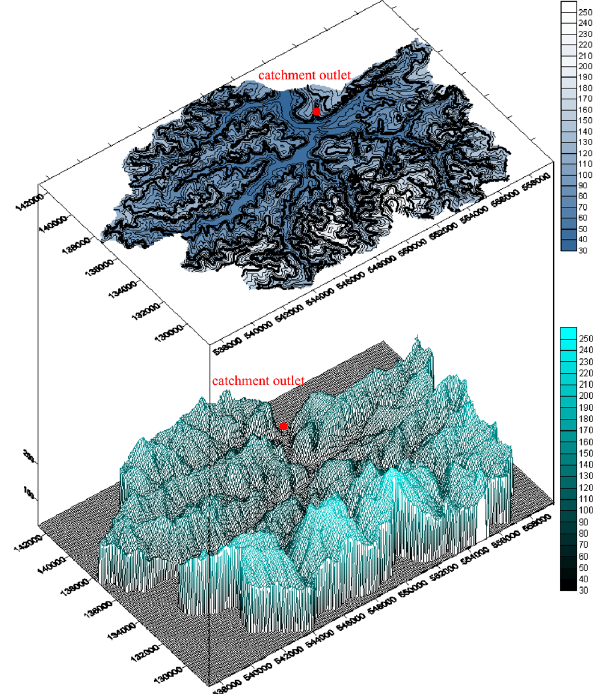
Fig. 6. Contours and DEM for the upper medway catchment (unit: metre). The X and Y-axis stand for the easting and northing coordi- nates of